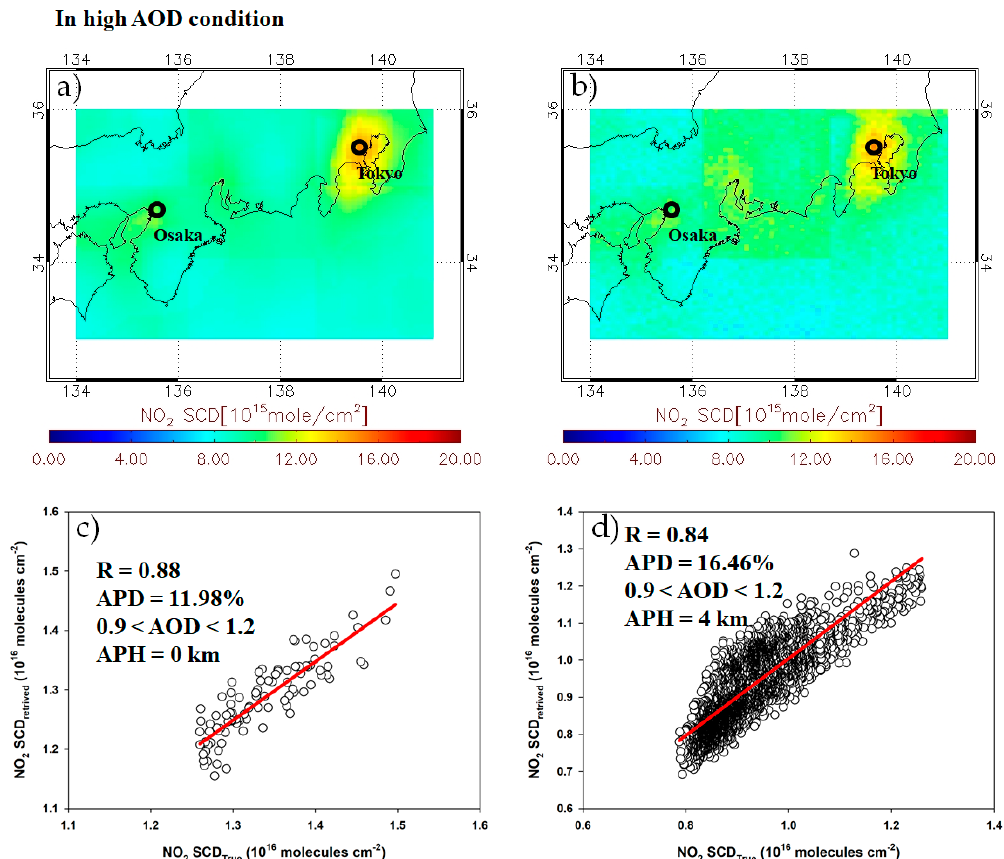
Figure 10. ( a ) True NO 2 SCD, ( b ) retrieved NO 2 SCD, and scatter plots of true and retrieved NO 2 SCD in ( c ) heavily polluted and ( d ) moderately polluted regions in Japan in December 2011 under high-AOD conditions. (Slant column density (SCD) and aerosol optical depth (AOD)).